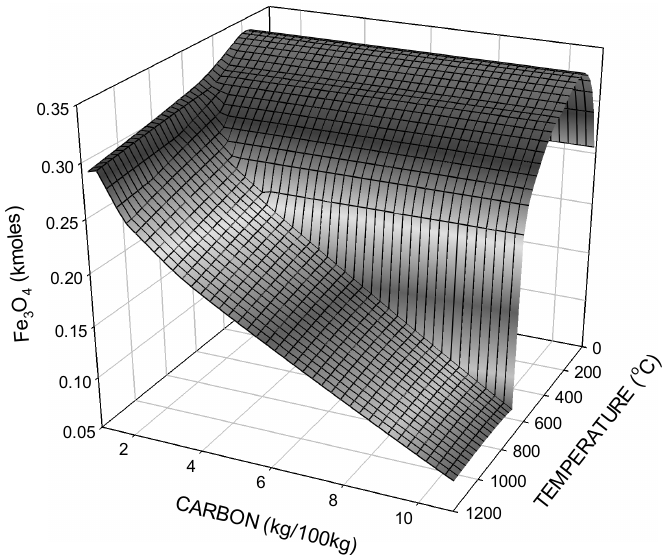
Figure 4. Effects of temperature and carbon additions on the amount of magnetite for the limonitic ore.